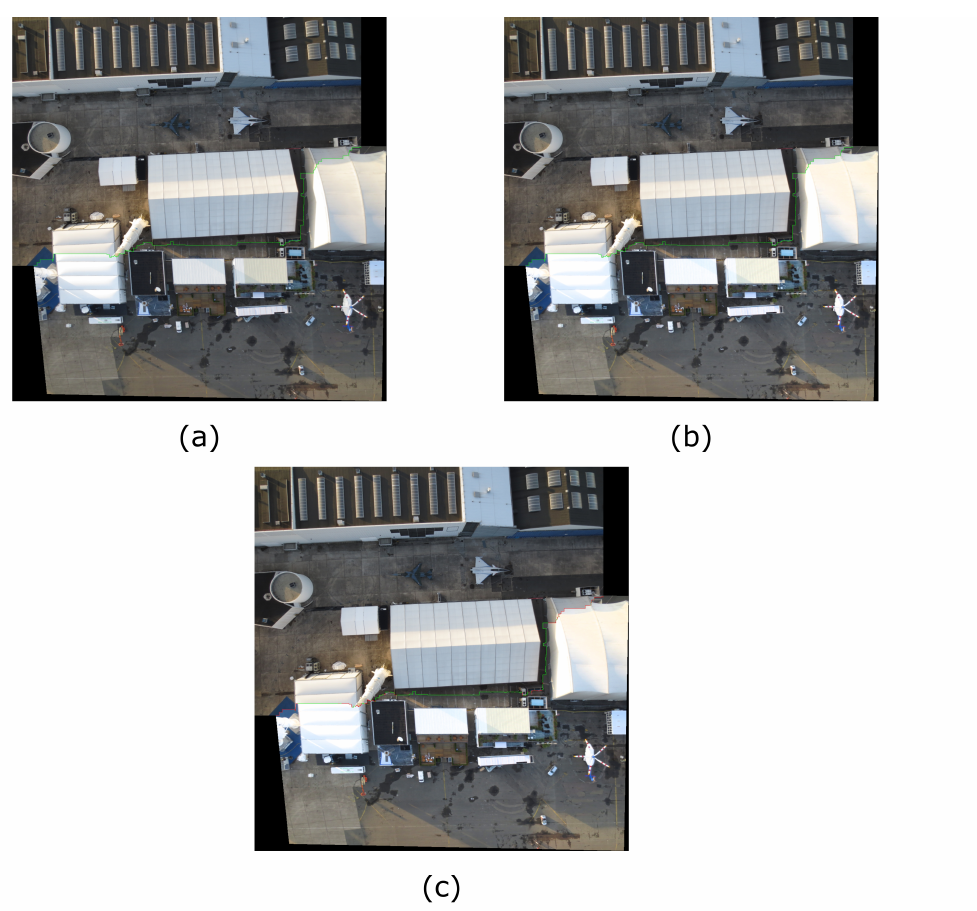
Figure 7. One updated stitched image and the partitioned stitching color difference values. ( a ) The original stitched image. ( b ) The updated stitched image by increasing 15% of the brightness of every target pixel in ( a ). ( c ) The partitioned stitching color difference